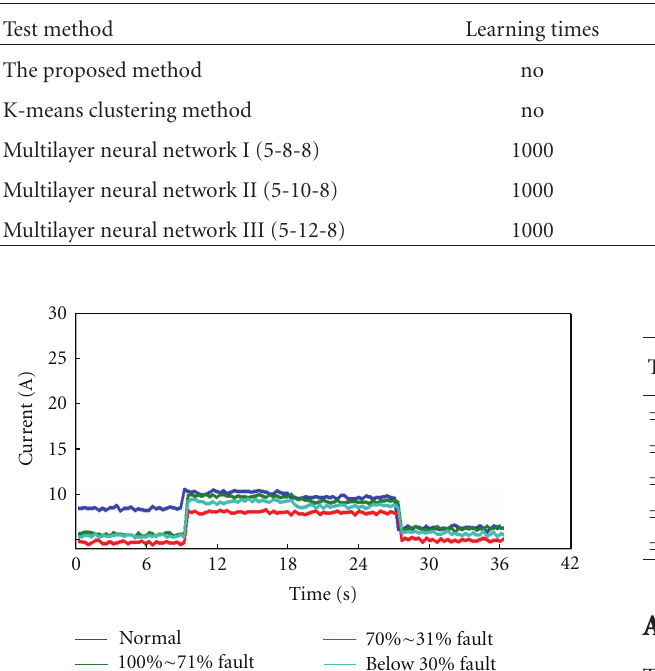
Table 5: The results of the fault diagnosis by night in di ff erent ways.